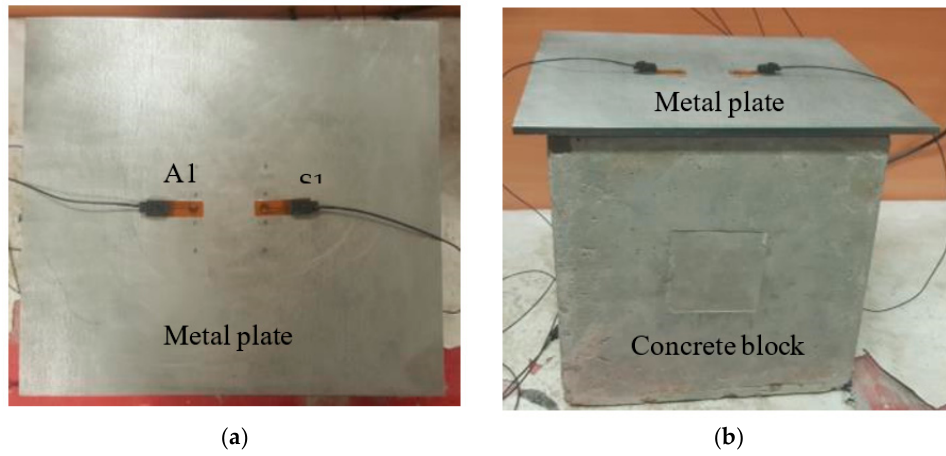
Figure 3. Photographic image of the experimental setup: ( a ) top view and ( b ) side view.